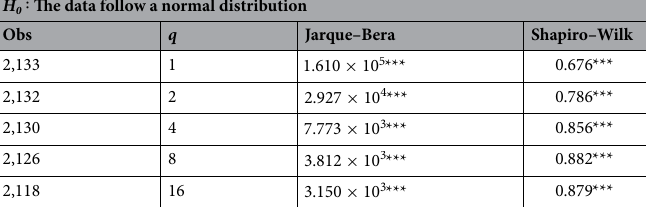
Table 3. Normality test results on the log return distribution of Bitcoin. Jarque–Bera test is run by χ 2 statistic, and Shapiro–Wilk test is by W statistic. The cutoff values for W are calculated through Monte-Carlo simulations. *** indicates significance at the 0.1% level. The sampling interval q is applied differently to the same data.